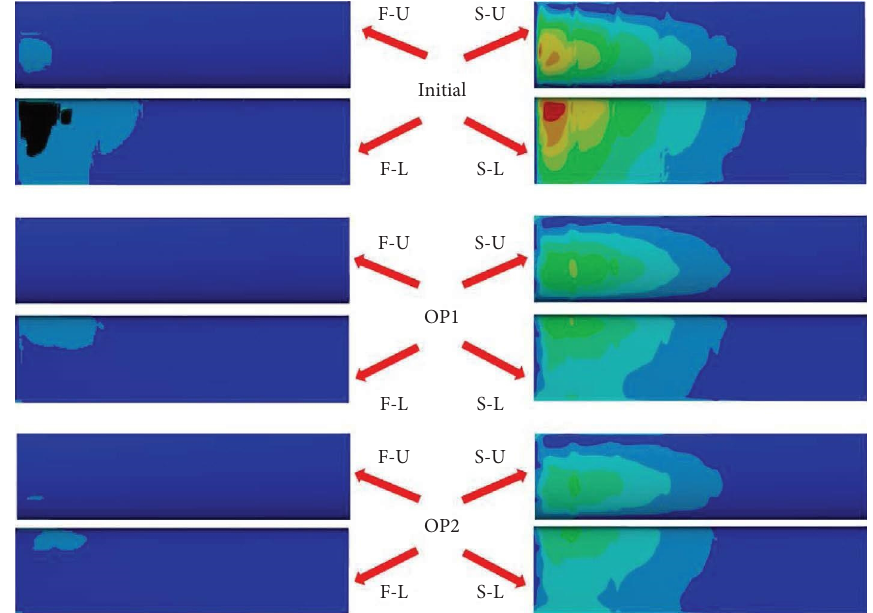
Figure 11: Failure-strain optimization results.